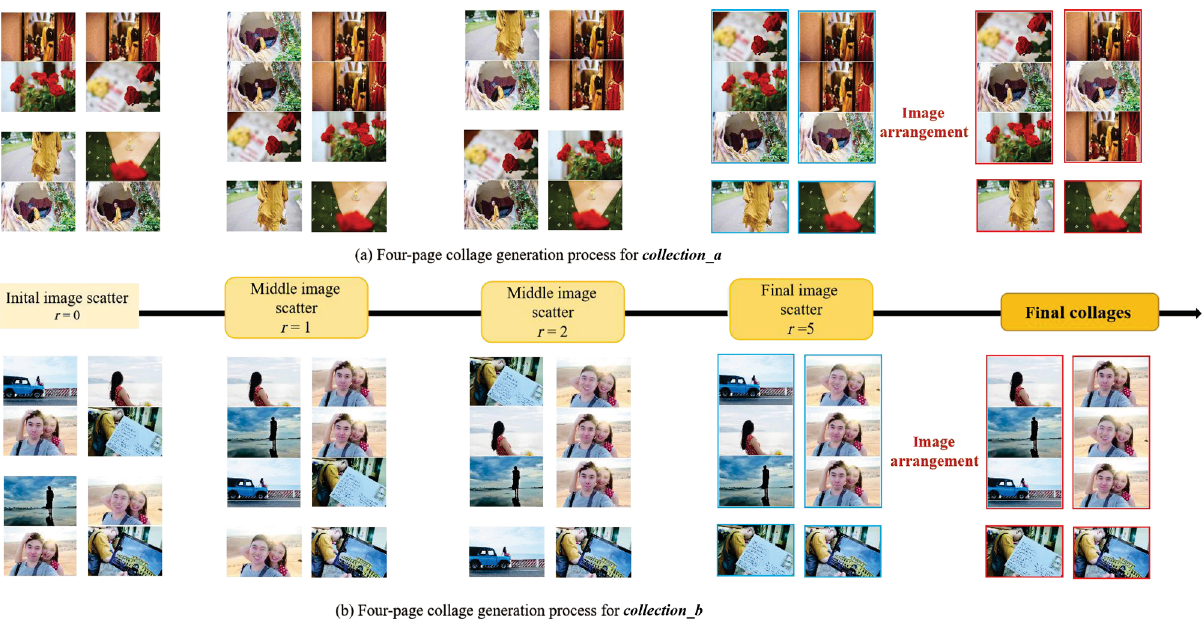
Fig. 9 Pipeline of four-page collage